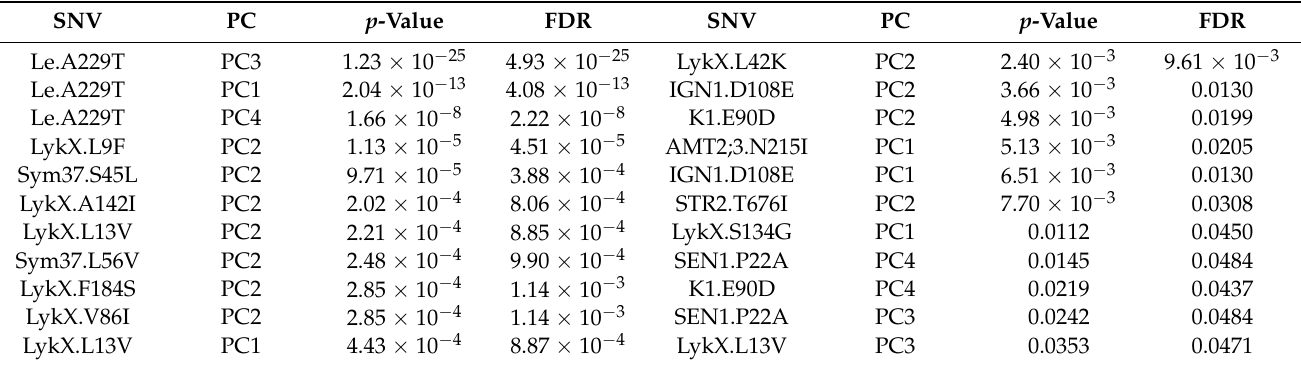
Table 6. Associations between SNVs and